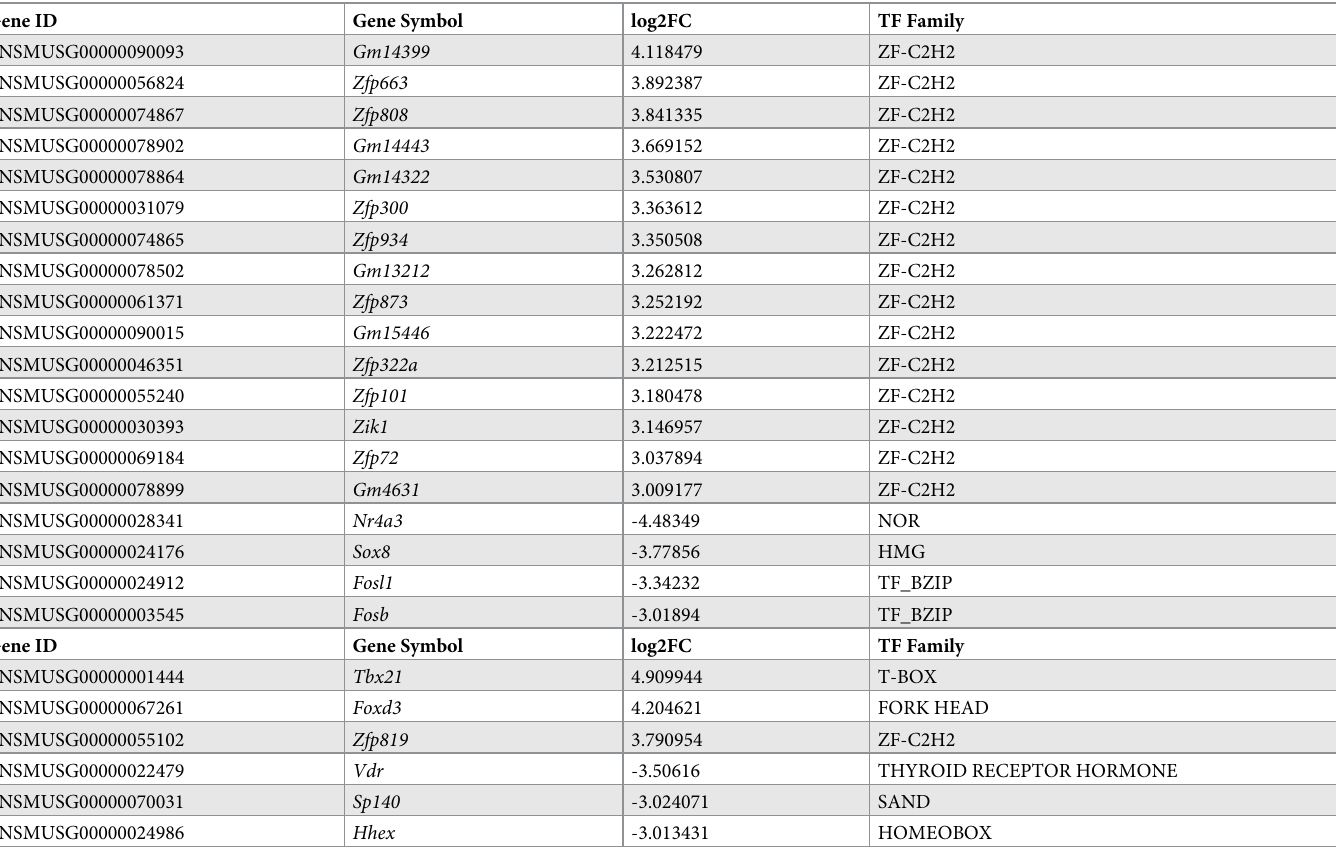
Table 3. List of highly differentially expressed Transcription factors (FC > 6, FDR < 0.001) in WT lung vs. Dip2a -/- lung and WT brain vs. Dip2a -/- brain respectively. Gene